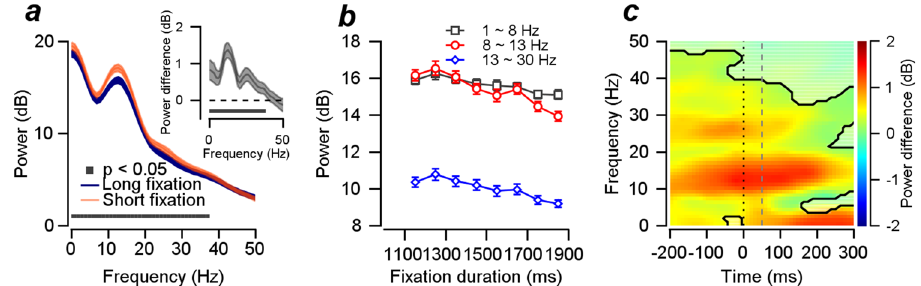
Figure 3. The effect of temporal expectation on the local field potential responses. ( a ) Average LFPs across 120 recordings in two fixation duration trials, estimated at a time window centered at 51 ms. Orange denotes the averaged power for low temporal expectation trials, and blue denotes the high temporal expectation trials. Colored areas show the standard errors. The inset shows the power difference. ( b ) Average LFP powers in three frequency groups plotted as a function of fixation durations. The error bars denote standard errors. ( c ) The LFP power difference between the fixation duration trial groups measured at time windows covering the duration of − 200 ms to 300 ms from motion onset. The black contour denotes statistically significant time and frequency regions (cluster-based permutation test, alpha = 0.05). The black dotted line shows motion onset timing, and the gray dashed line shows the time window for the data in Fig. 3a.